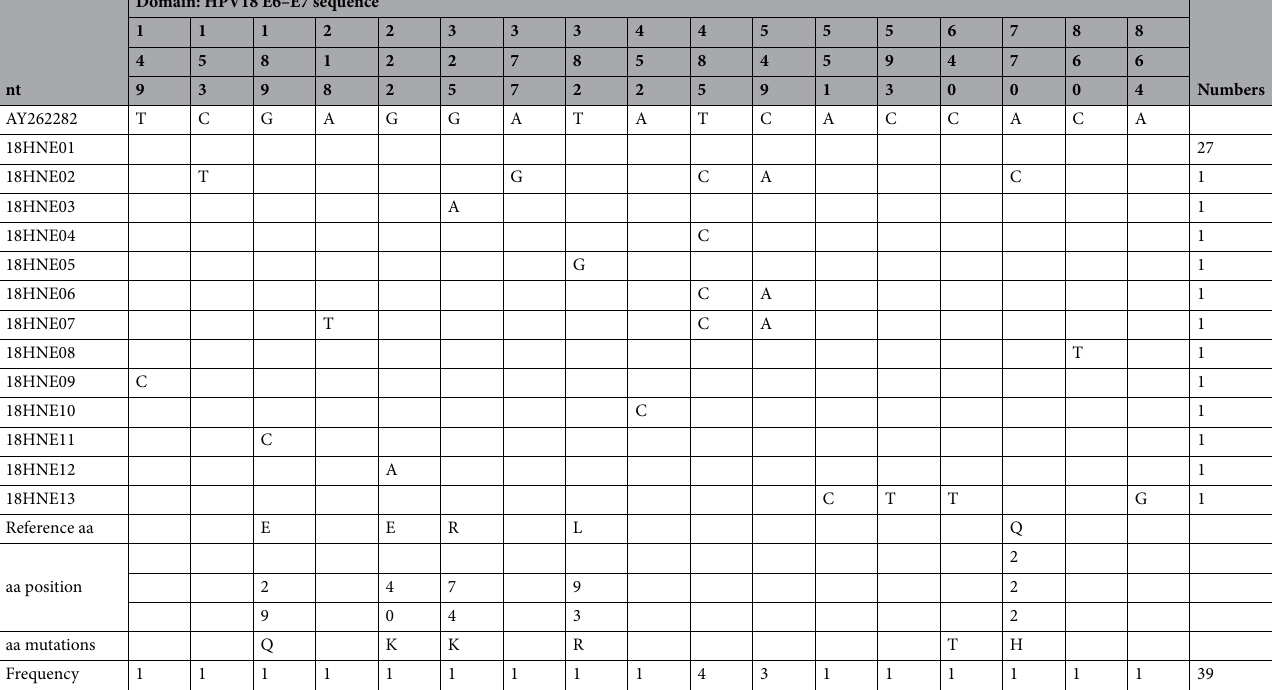
Table 4. Nucleotide sequence mutations of HPV18 E6-E7 genes. Positions without variants are marked with blank, whereas positions with variants are indicated by a letter.